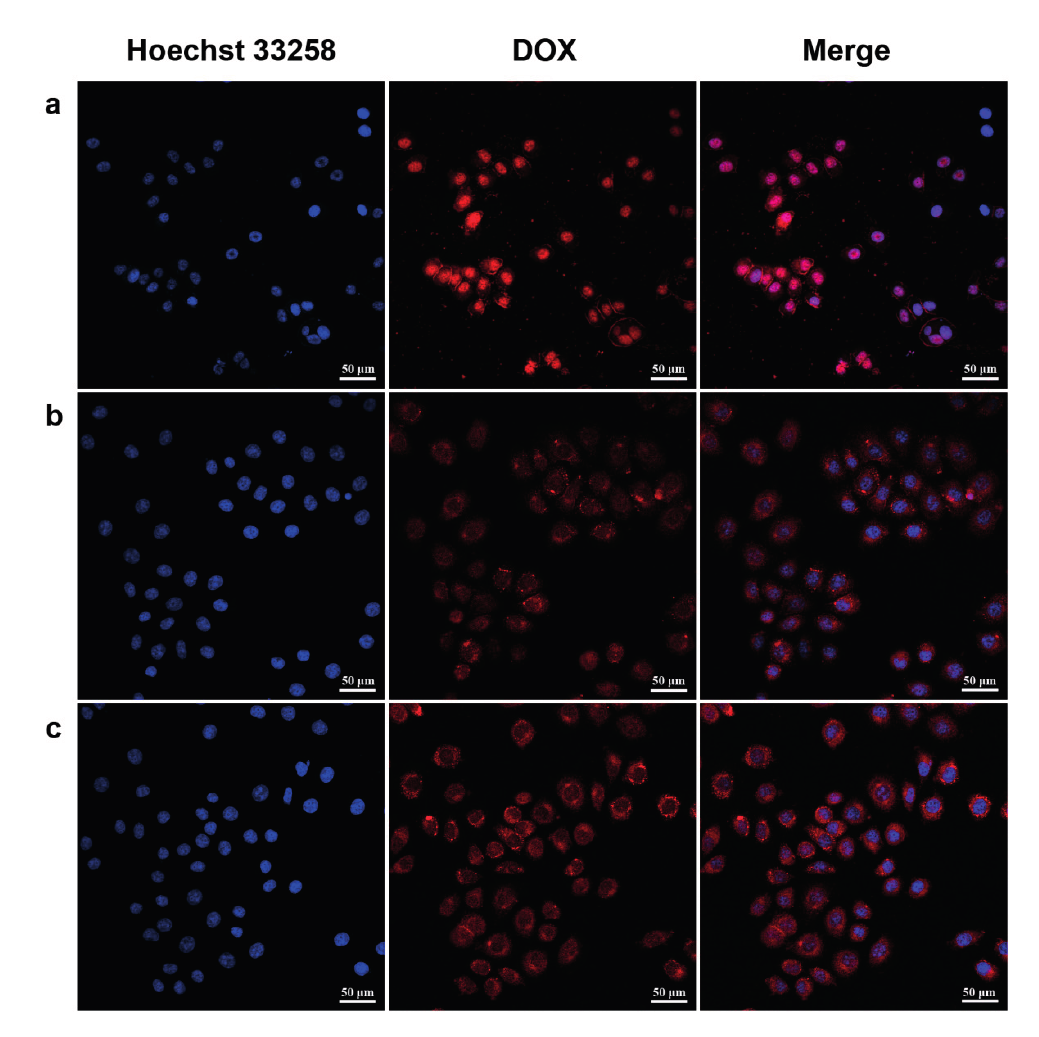
(CLSM) images of HeLa cells incubated with DOX·HCl ( a ), DOX-conjugated PEG-PGD and PEG-PG D ( c ) micelle for 4 h with a DOX concentration of 10 μ g/mL (scale bar 50 μ 2 I